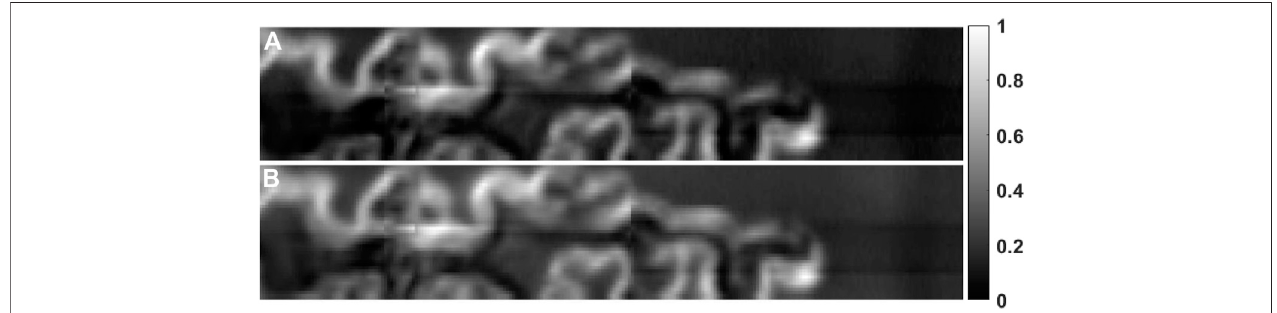
FIGURE5|(A) THztime-domain parametricimage(maximumoftemporalamplitude). (B) THzfrequency-domainimage(integralofthespectralamplitudeoverthe 0 – 2.6-THzfrequencyrange).Bothpanelsarenormalized,sotheycanshareacolorbar.There isaproblemthatneedstobeexplained:althoughtheXYscansteplength is0.25 mm,butitshorizontalresolutionis1 mm.ThisisbecausethesizeoftheTHzwavefocusislimitedbythewavelengthandspectralwidth.Wearecurrentlyworking to improve the horizontal resolution.